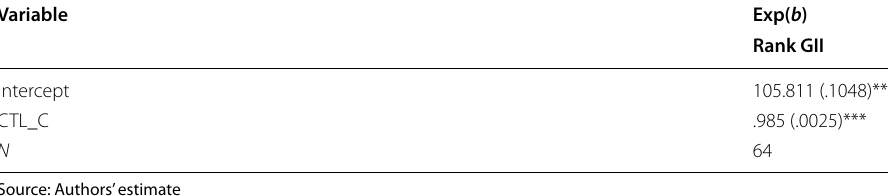
Table 6 Regression Rank Global Innovation Index